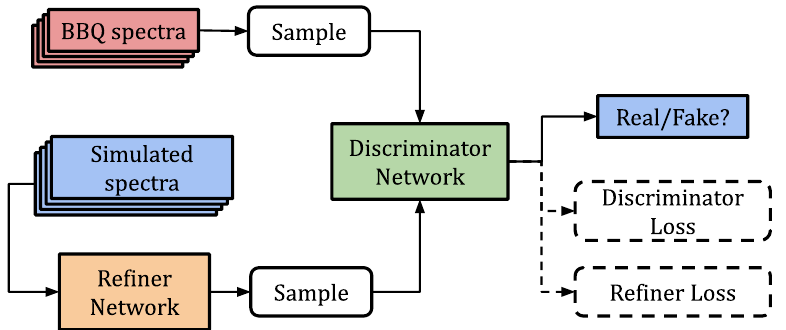
Figure 12. Overview of the SimGAN